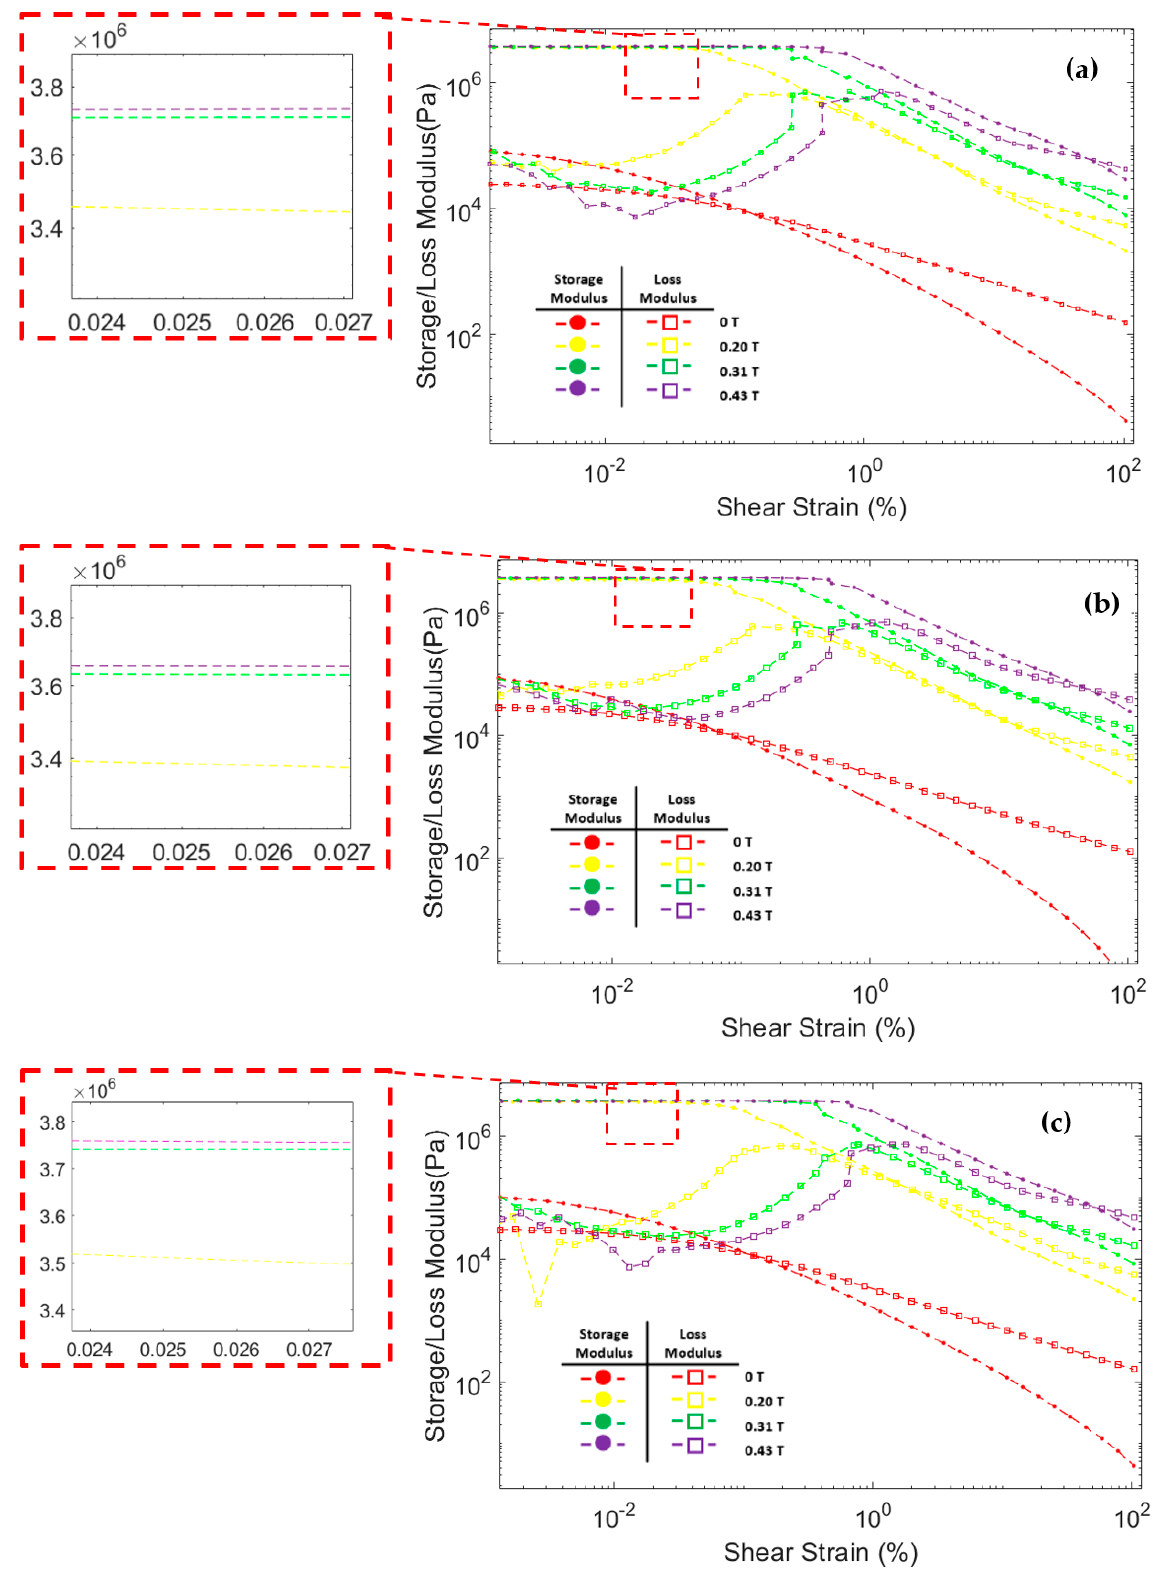
Figure 8. Storage modulus and loss modulus curve against the shear strain of MRF ( a ) CIP-Base ( b ) CIP+Sr-CoFe 2 O 4 -T300 ( c ) CIP+Sr-CoFe 2 O 4 -T400. The loss modulus of all MRF samples at small shear strain has a relatively low value.